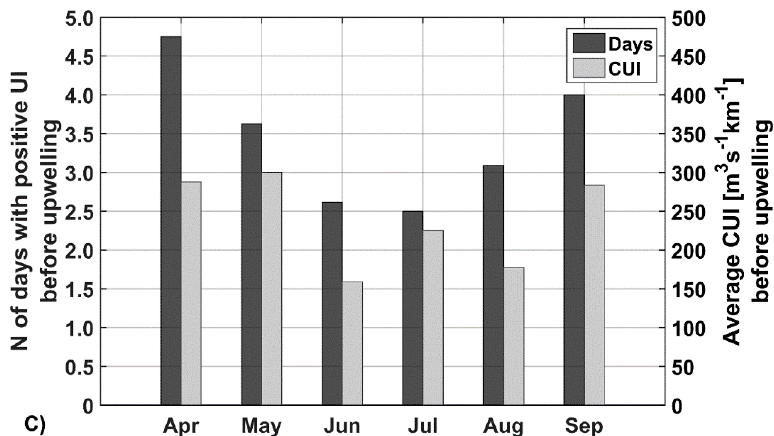
Figure 5. Meteorological conditions prior to coastal upwelling development in the SE Baltic Sea. ( a ) Number of days with positive UI values before the first manifestation of coastal upwelling in thee satellite data; ( b ) cumulative upwelling index for all of the coastal upwelling events identified in the satellite data; ( c ) seasonal distribution of ( a , b ).